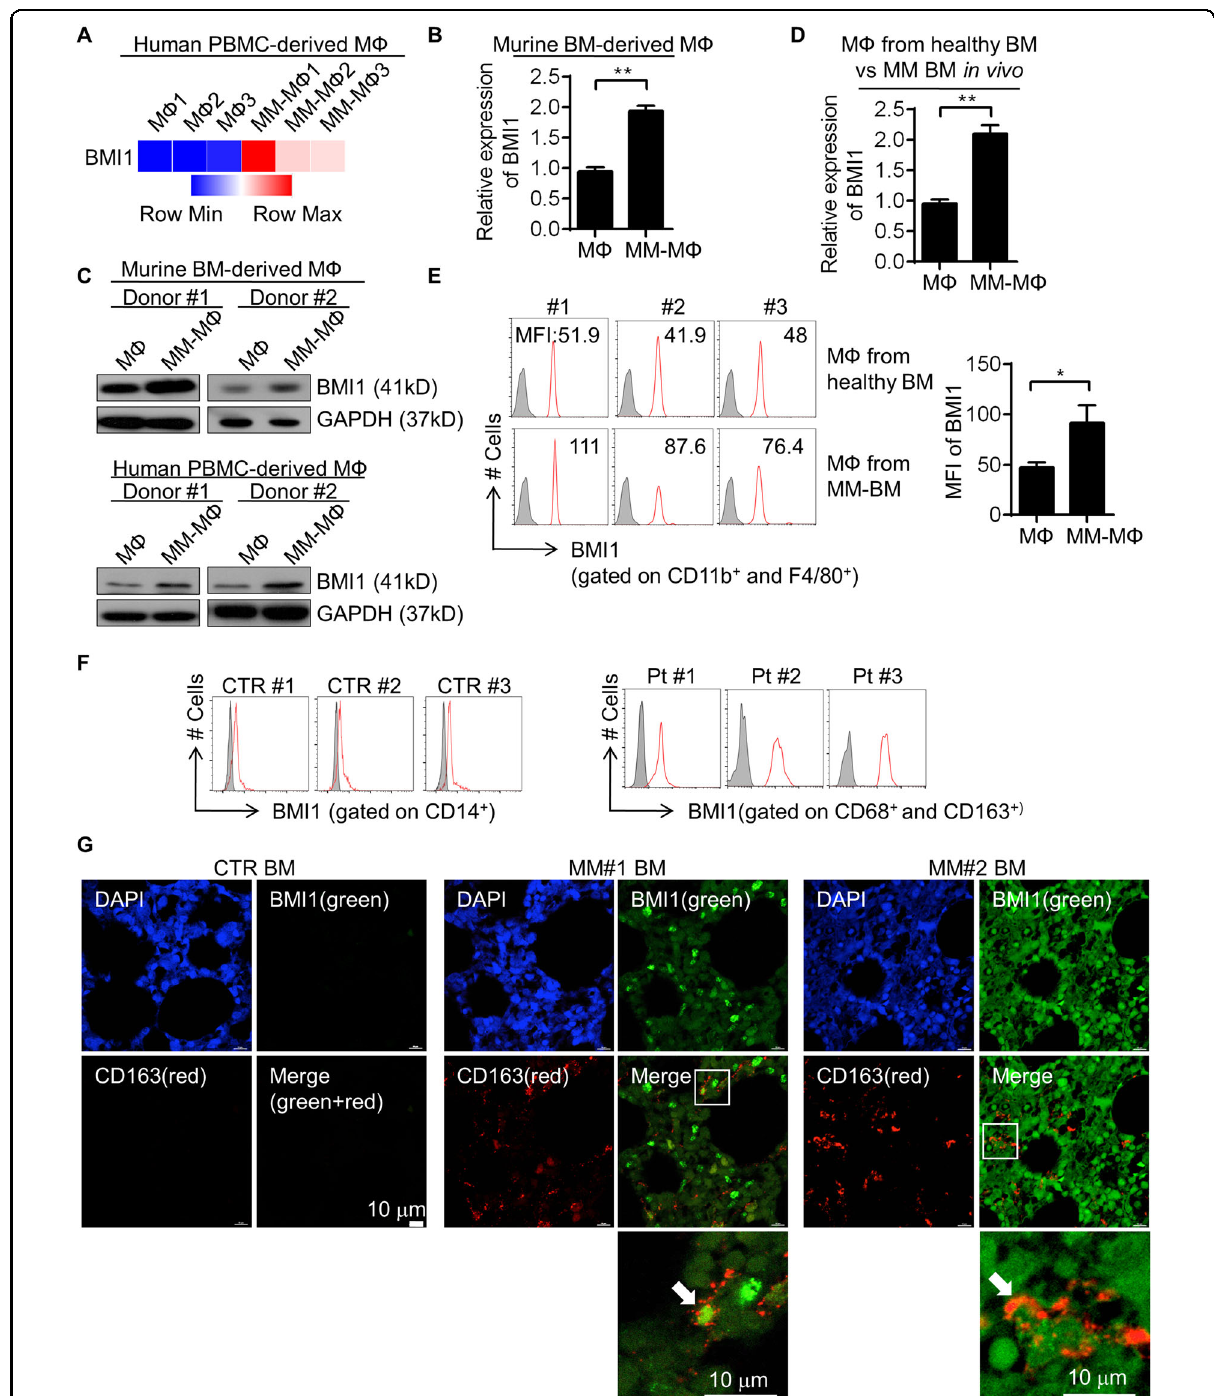
Fig. 2 BMI1 overexpression in MM-M Φ s. A In human peripheral blood monocytes derived M Φ s and MM-M Φ s, transcriptional microarray analysis showed higher expression of BMI1 in MM-M Φ s. B In murine bone marrow derived M Φ and MM-M Φ , RT-qPCR showed relative higher BMI1 mRNA expression in MM-M Φ s. Statistical signi fi cance was determined by two-tailed Student t -test between M Ф s and MM-M Ф s, ** P <0.01. C Western blot showed in both murine BM-derived and human PBMC-derived in vitro culture systems, MM-M Φ s had higher BMI1 protein levels. D MM-M Φ s from the 5T myeloma mice BM expressed higher BMI1 mRNA than M Φ s from the healthy mice BM. E Left, fl ow cytometry histograms showed higher BMI1 levels in M Φ s from myeloma mice BM. Right panel, statistic result of the mean fl uorescence intensity (MFI) of BMI1 in M Φ and MM-M Φ . Statistical signi fi cance was determined by two-tailed Student t -test between M Ф s and MM-M Ф s, * P <0.05. F Left, fl ow histograms showed the expression of BMI1 in BM CD14 + monocytes from 3 of 5 noncancer patients tested. Right, fl ow histograms showed the expression of BMI1 in BM M Φ s from 3 of 5 MM patients tested. G Immuno fl uorescent staining of BM sections from 1 of 3 noncaner control donors and 2 of 5 MM patients showed more M Φ s in the MM BM with higher BMI1 expression. Of fi cial journal of the Cell Death Differentiation